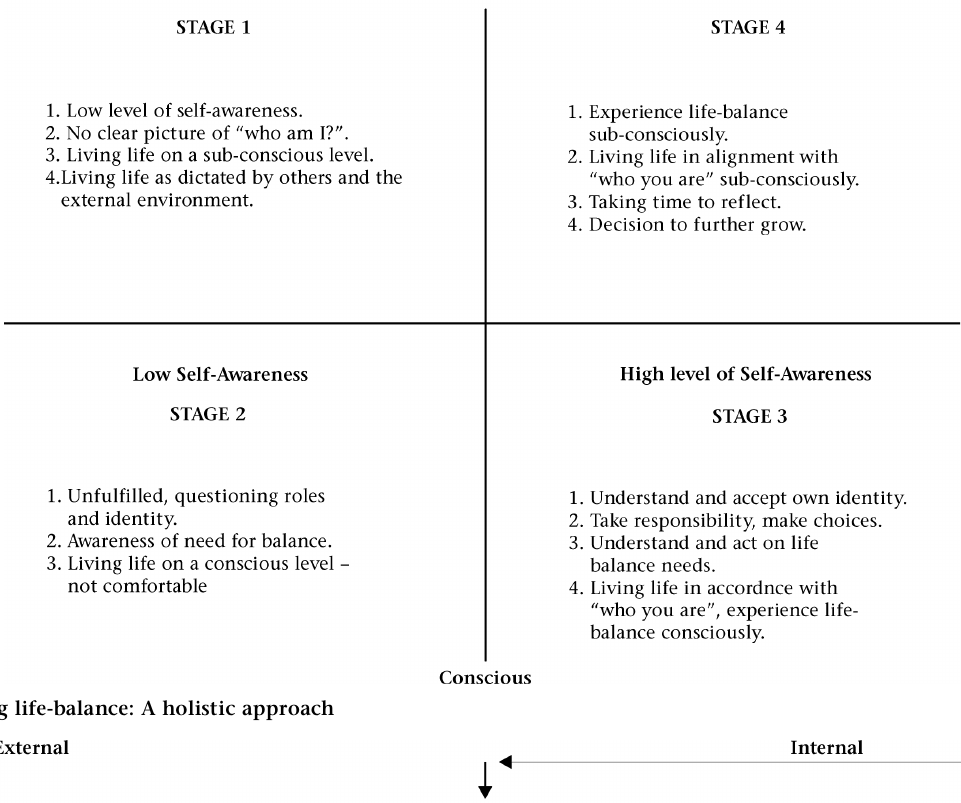
Figure 1: Defining life-balance: A holistic approach